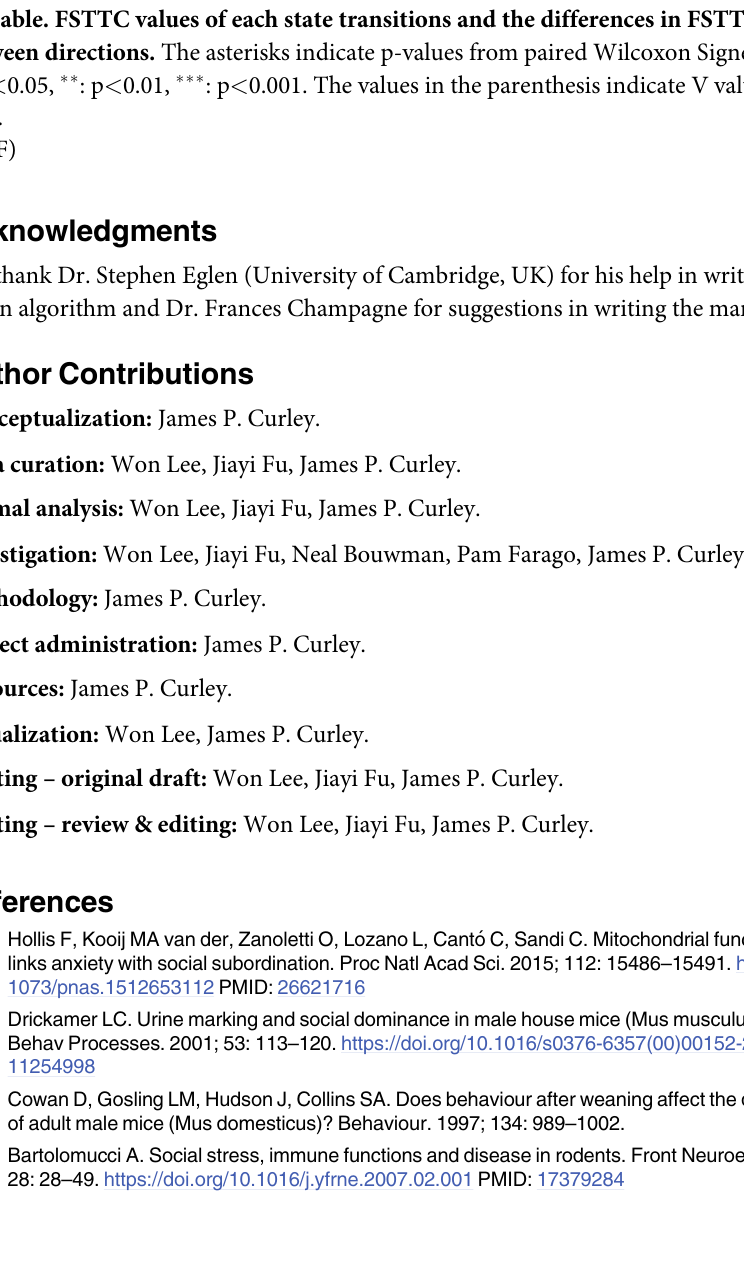
S1 Table. The difference in durations of behaviors between dominant and subordinate mice across three phases (paired Wilcoxon Signed Rank Sum Tests). The value in parenthe- sis is p-value and asterisks indicate; � : p < 0.05, �� : p < 0.01, ��� : p < 0.001. S2 Table. The median probability of behavioral transition within individuals and its signif- icance tested based on permutation. Asterisks indicate; �� : p < 0.01, ��� : p < 0.001. We conser- vatively considered the transitions to be significant if p � 0.01 and only significant p-values of transitions are displayed. S3 Table. FSTTC values of each state transitions and the differences in FSTTC values between directions. The asterisks indicate p-values from paired Wilcoxon Signed Rank